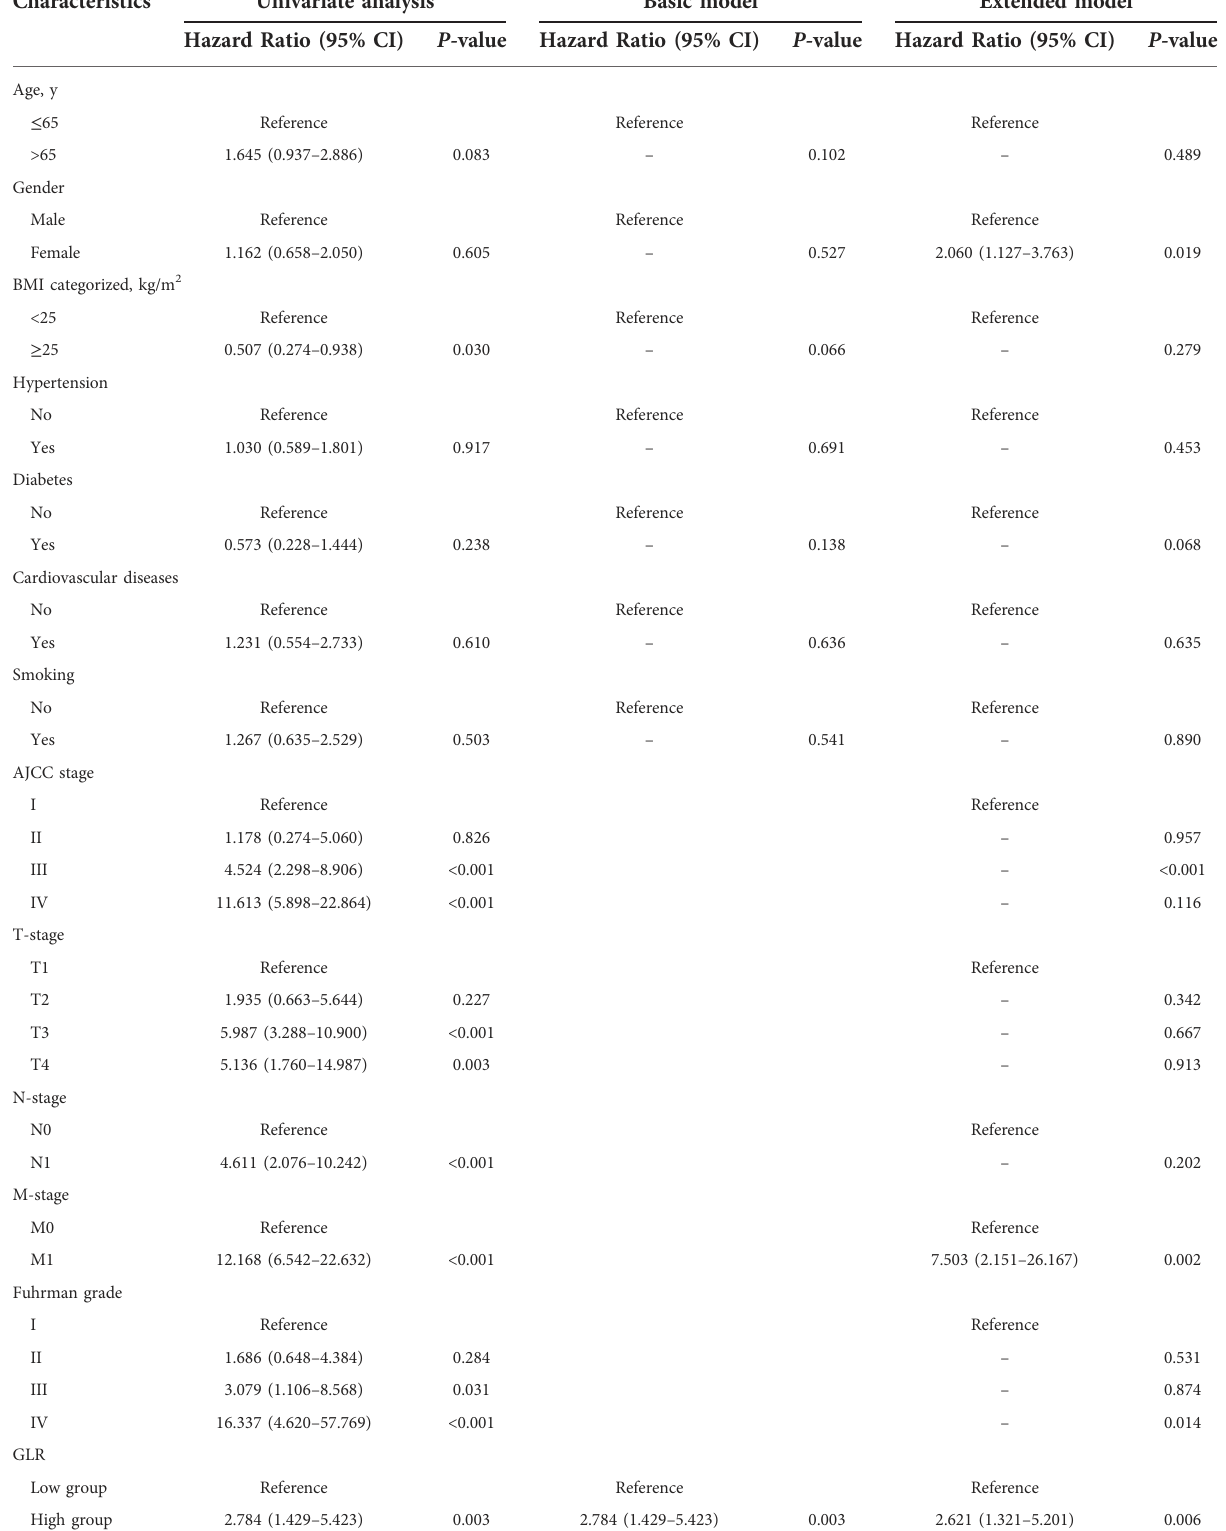
TABLE 2 Univariate and multivariate analyses of factors associated with overall survival